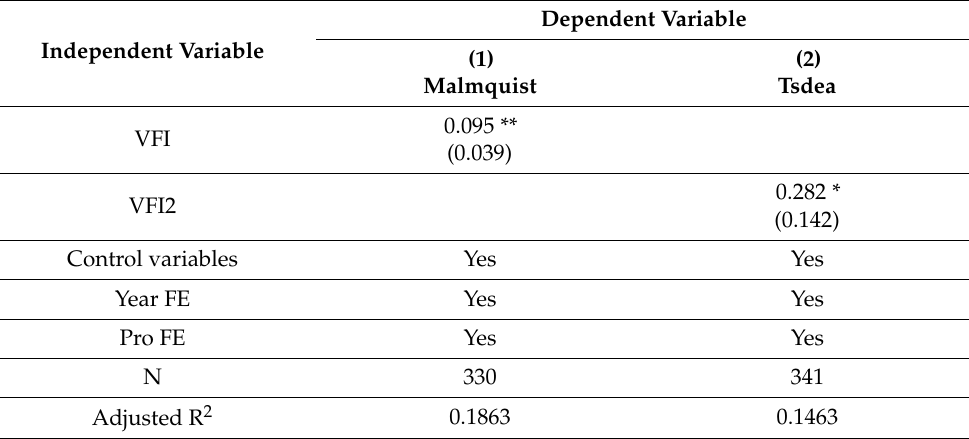
Table 4. Empirical results of the impact of vertical fiscal imbalance on fiscal health expenditure efficiency in China (robustness